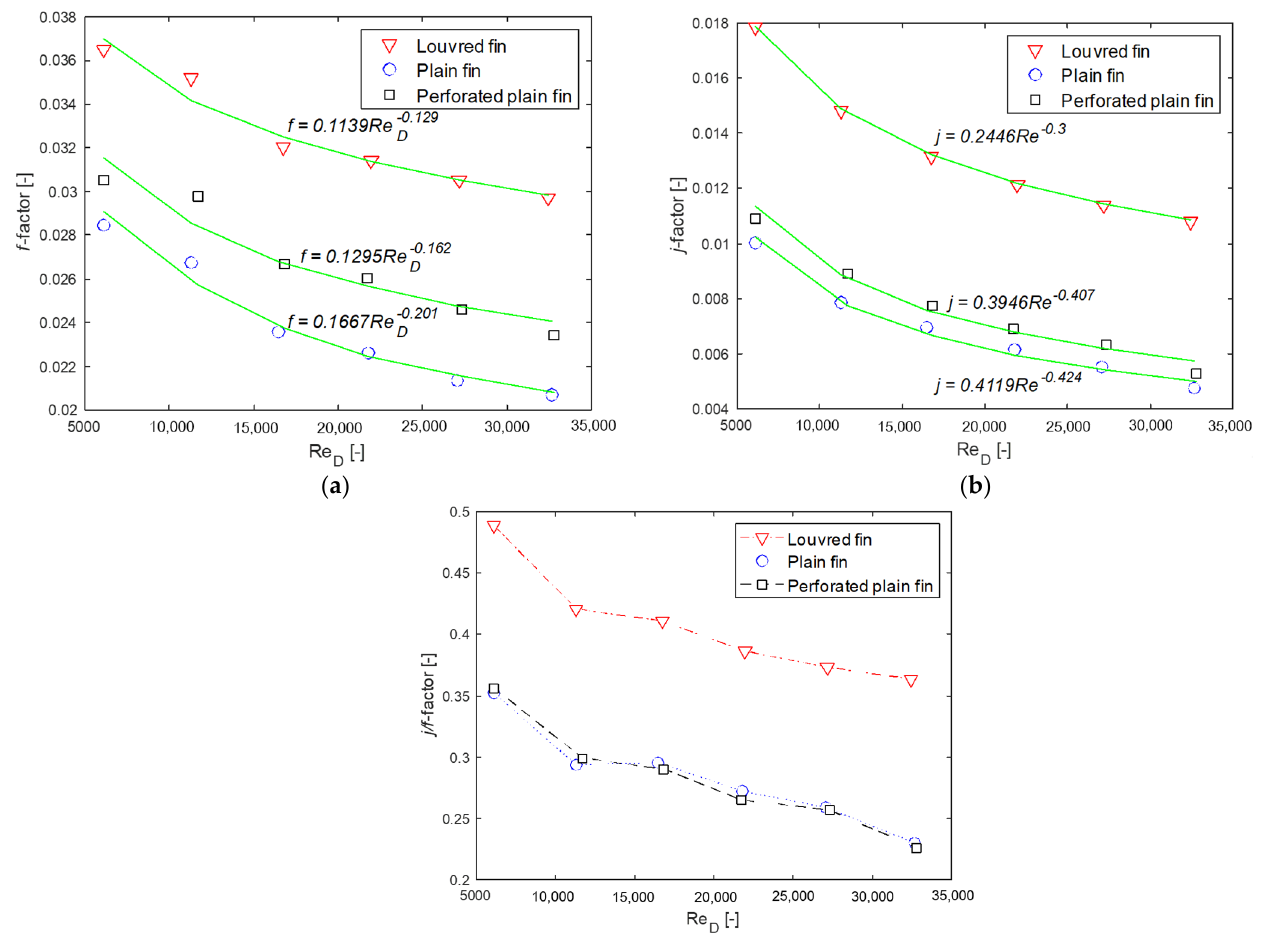
Figure 7. Variations of ( a ) friction f-factor ( b ) Colburn j-factor and ( c ) efficiency index j/f for different fin arrangements as a function of Reynolds number.